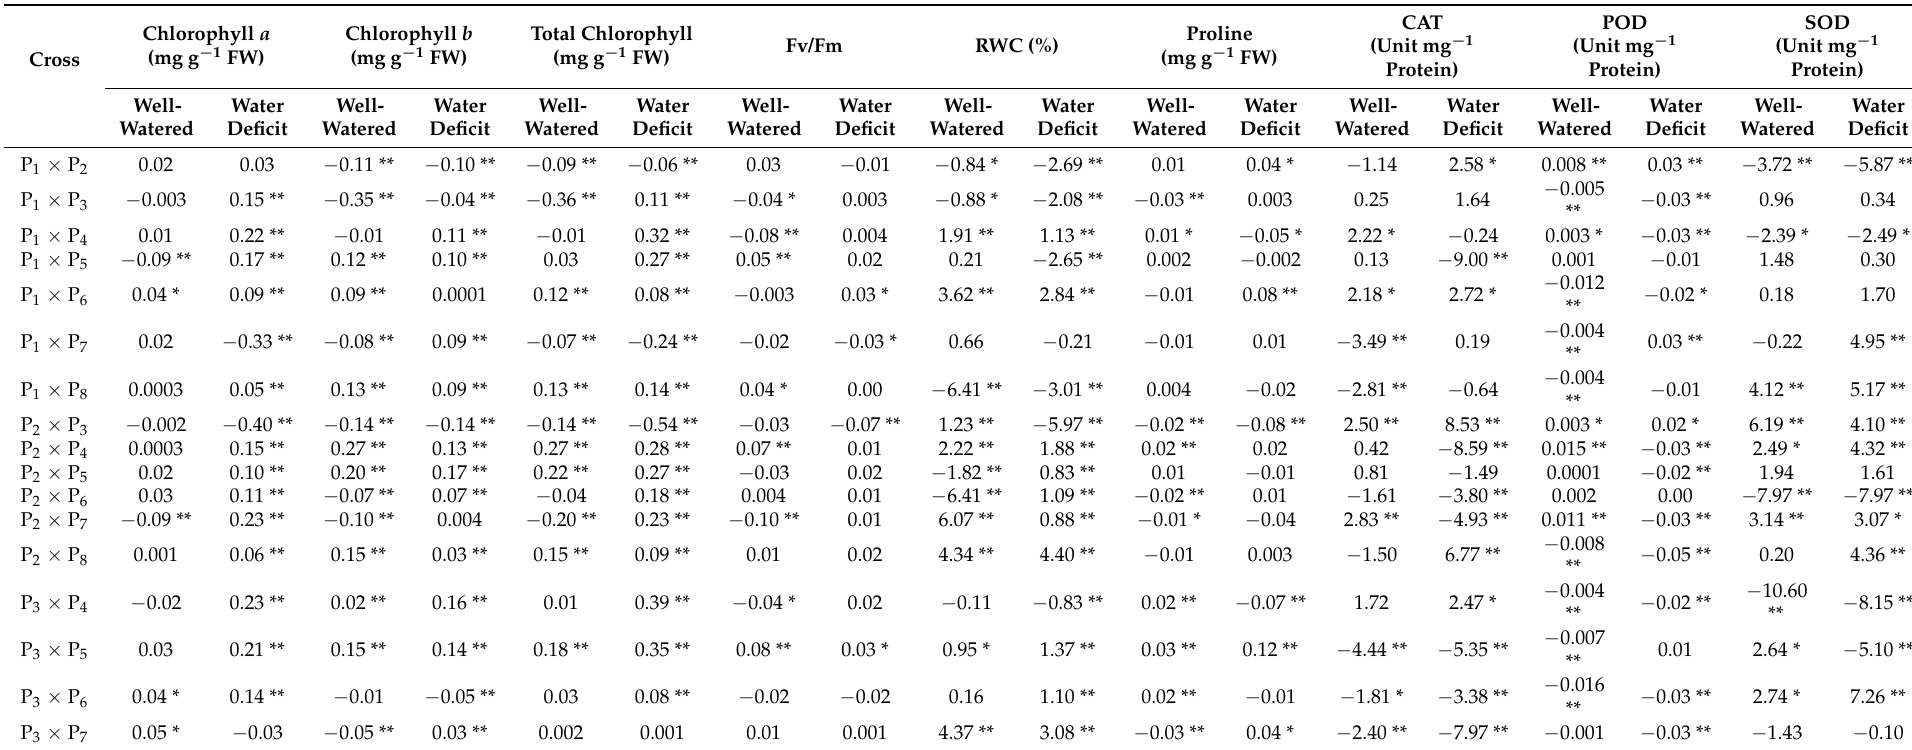
Table 3. Specific combining ability effects (SCA) of 28 F 1 cross combinations for all studied traits under well-watered and drought stress